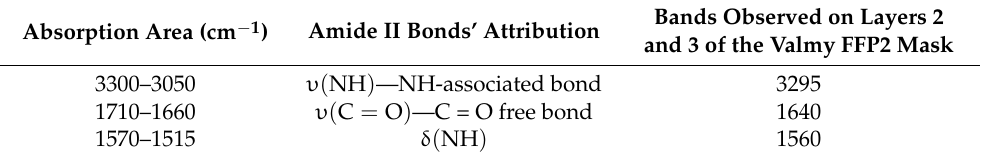
Table 2. Attribution of the additional bands observed in the infrared spectra of layers 2 and 3 of the Valmy FFP2 mask (Lifshutz, 1997). ν : stretching; δ : bending. Absorption Area (cm − 1 ) Amide II Bonds’ Attribution